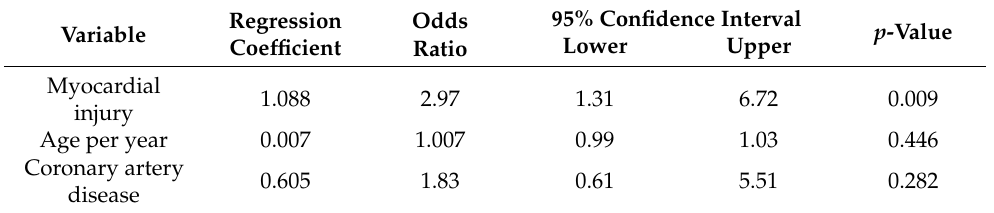
Table 3. Multivariate binary logistic regression model for myocardial injury and AKI within 72 h. Regression Variable Coefficient